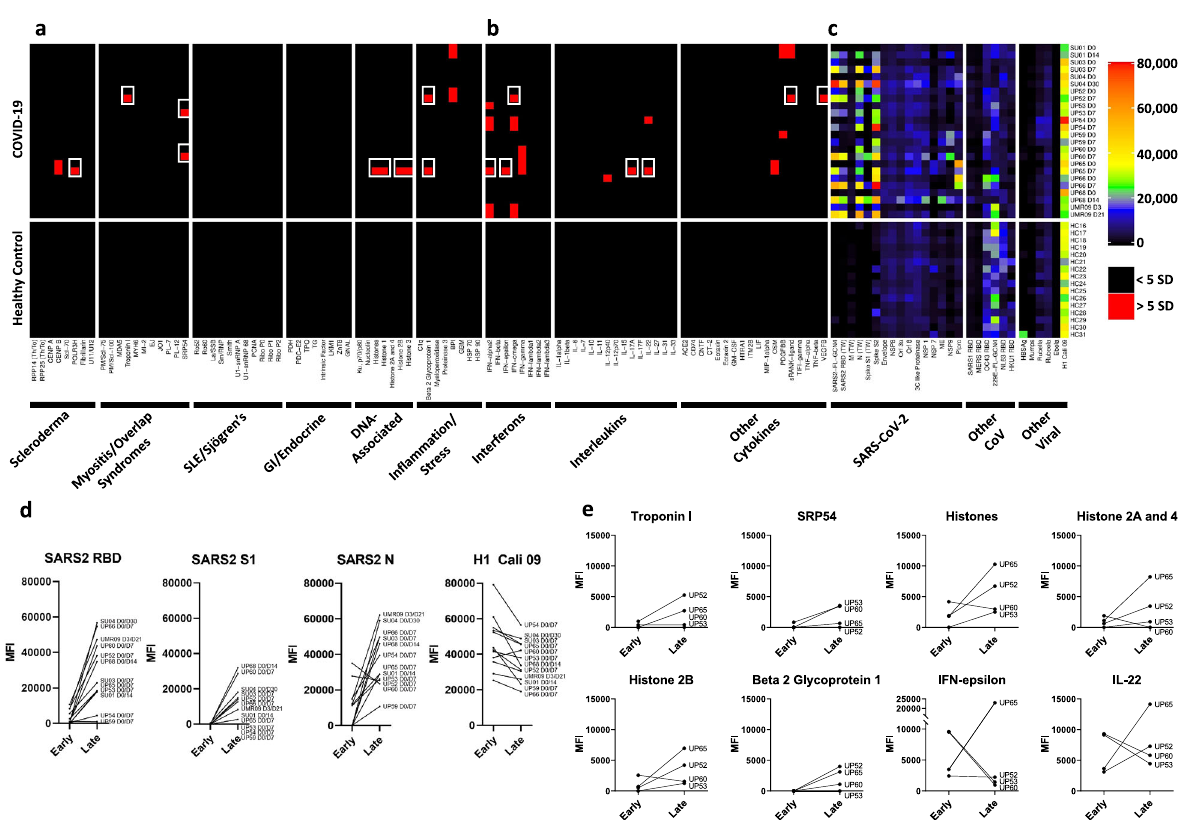
Fig. 5 New-onset autoantibodies correlate with anti-SARS-CoV-2 IgG responses over time in recently infected patients who developed COVID-19. Twelve patients were identi fi ed who had low or absent anti-SARS-CoV-2 RBD or spike S1 protein responses at baseline and who went on to develop high MFI IgG SARS-CoV-2 antibodies at the next available time point. Autoantigen data ( a ) and ACA data ( b ) from Supplementary Figures 9 and 10 (using 5 SD and MFI > 3000 cutoffs) for these 12 patients and HC has been combined with anti-viral heatmap data from Fig. 4 ( c ). Multiple new autoantibodies are depicted with white boxes. Antigens are shown on the x -axis. Patients and HC are shown on the y -axis. Colors for viral IgG levels correspond to the MFI values shown at the far right. d Line graphs comparing MFI for IgG antibodies against four viral proteins at Early (D0) and Late (D7) time points for the same 12 patients in a – c . e Line graphs comparing MFI for IgG autoantibodies against eight autoantigens or cytokines at Early (D0) and Late (D7) time points for 4 patients in a – d . Source data are provided as a Source Data fi